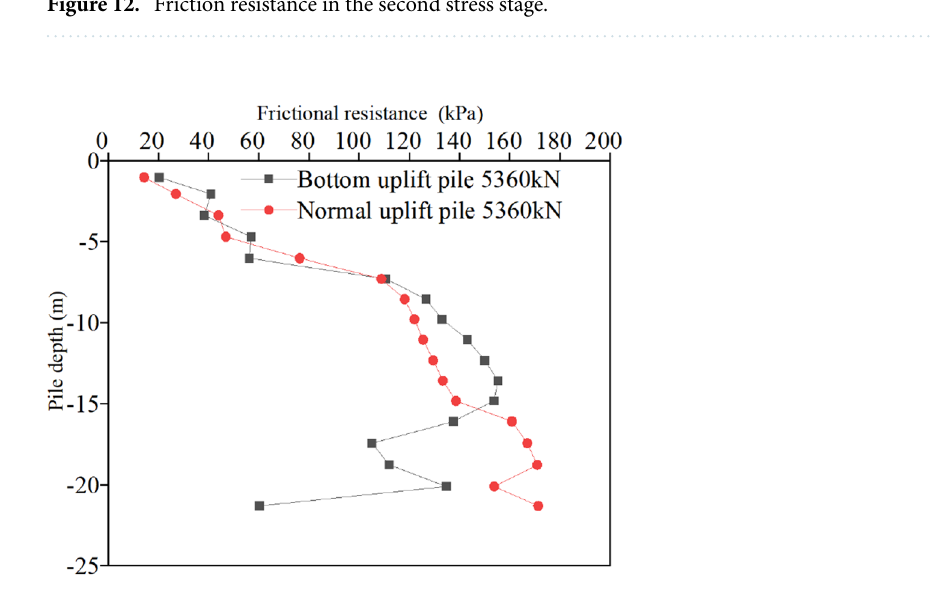
Figure 13. Friction resistance in the third stress